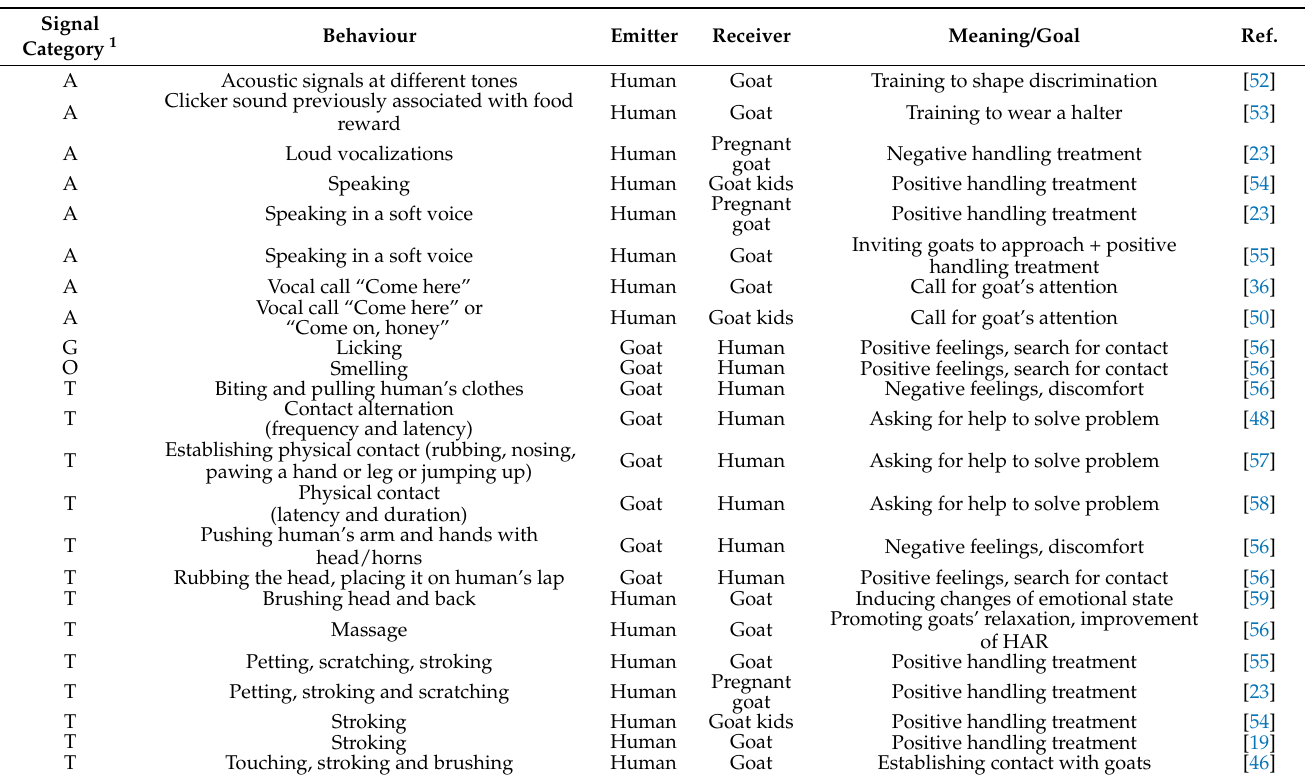
Table 1. Effective intentional communication signals between goats and humans, and vice